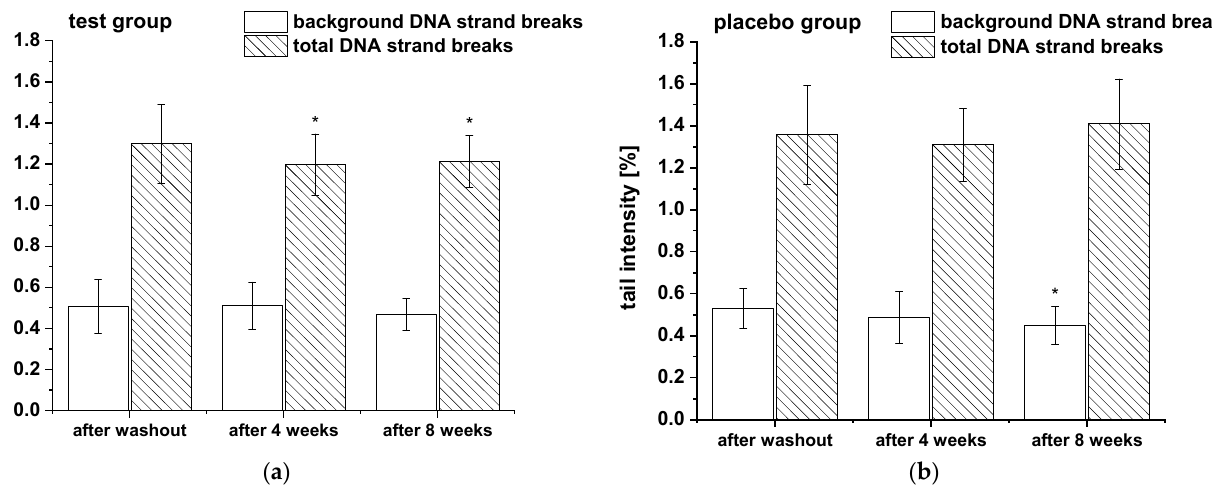
pared to washout period.